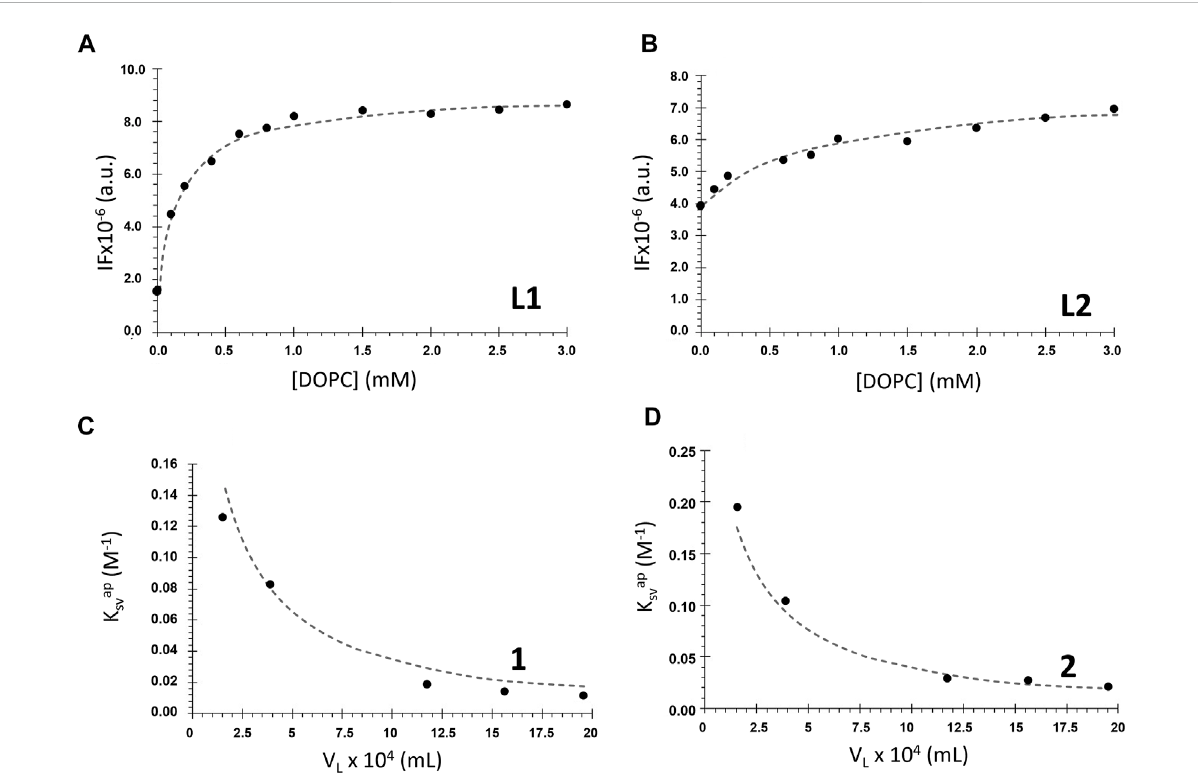
FIGURE 5 Membrane/waterpartitioncoef fi cientdetermination fortheligands L1 and L2 andcomplexes 1 and 2 . (A) , (B) Ligands fl uorescenceintensity(IF) inthepresenceofDOPCLUVswithincreasinglipidconcentrations( buffer1 ,c quenching of di-4-ANEPPS fl uorescence by the complexes as a function of the lipid phase volume in 1 ml of LUVs suspension ( buffer 2 , c 1 : 0 – 22 μ M; c 2 : 0 – 24 µM). The dashed line represents the non-linear fi t of Eq. 12 to the data.